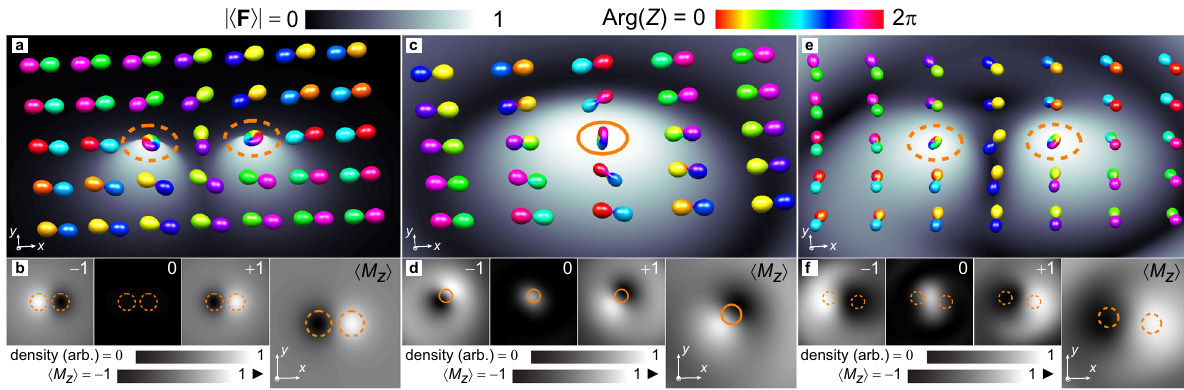
Fig. 6 Numerical simulation of singly-quantized vortex (SQV) core deformation and half-quantum vortex (HQV) formation. a Spin magnitude (background surface, upper grayscale bar) and order-parameter symmetry after pure energy relaxation in a 23 Na condensate c 0 / c 2 ≃ 28) with q = − 0.1 ℏ ω r , resulting in HQVs. The symmetry of the order parameter is represented as the surface of ∣ Z ( θ , ϕ ) ∣ 2 , where Z ð θ ; ϕ Þ ¼ expands the spinor in terms of the spherical harmonics Y 1, m ( θ , ϕ ), parameterized by local spherical coordinates ( θ , ϕ ). The color map shows Arg ð Z Þ . b Corresponding spinor-component densities (labeled by m , middle grayscale bar) and longitudinal magnetization density pro fi le ( 〈 M z 〉 , lowest grayscale bar). c , d As ( a , b ) for a 87 Rb condensate ( c 0 / c 2 ≃ − 216) with q = 0.01 ℏ ω r and η = 0.02. The spinor components exhibit density pro fi les similar to HQVs even though the vortex has not split. e , f As ( c , d ), but with complete splitting for q = 0.55 ℏ ω r , corresponding to the experiment, and η = regions of opposite longitudinal magnetization density on a size pronounced in, e.g., Fig. 4c, d, where the m = + 1 ( m = − 1) spinor component is shifted to the right (left). Nevertheless, the